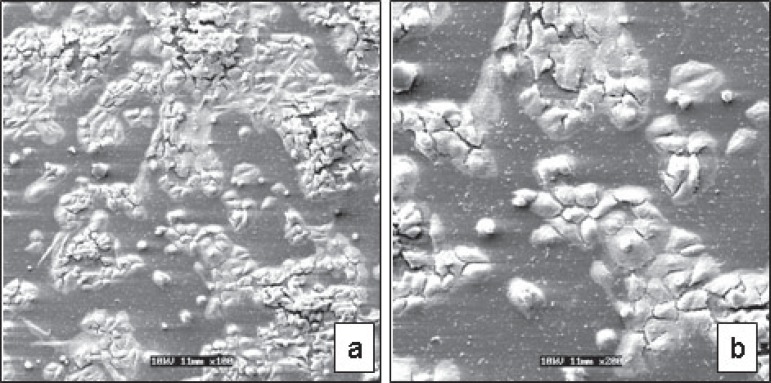
0.06% chlorexidine - 60 s. (a): A marked alteration of cell morphology was
observed for all exposure times [Scanning Electron Microscopy (SEM)
original magnification ×100)]. (b): Detail of Fig. 3a at greater magnification showing a
smaller number of cells adhered to the glass substrate. (SEM original
magnification ×200)